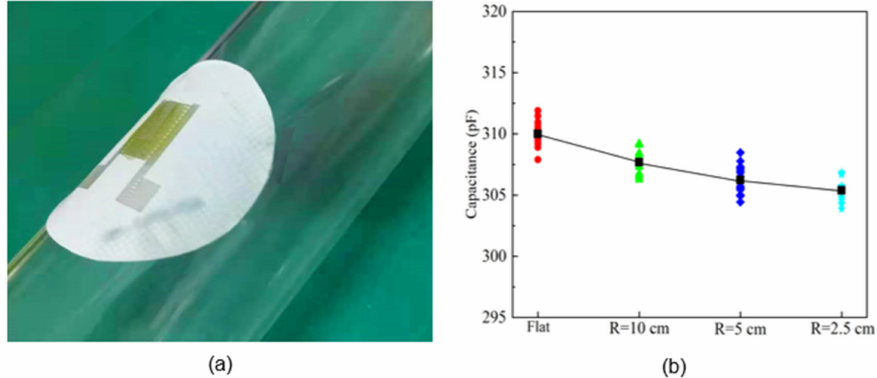
Figure 14. Effect of different bending conditions on sensor capacitance: ( a ) device; ( b )